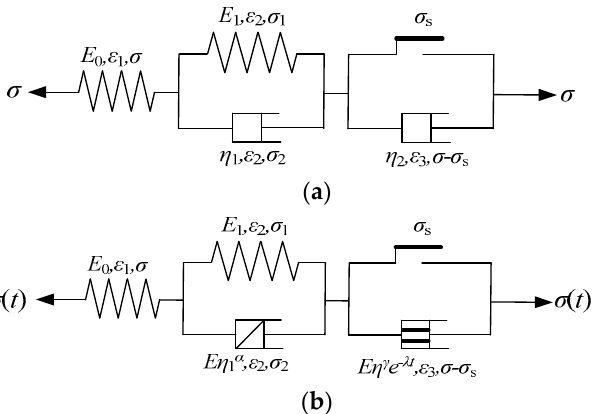
Figure 9. The distributed order damage creep model of the rock mass. ( a ) The integer-order Nishihara model, ( b ) The distributed order damage Nishihara model.